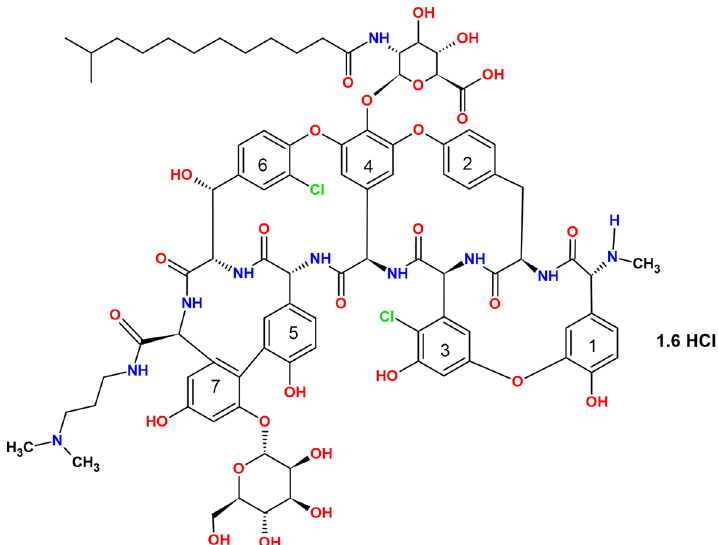
Fig. 1 Dalbavancin structural formula (DALVANCE